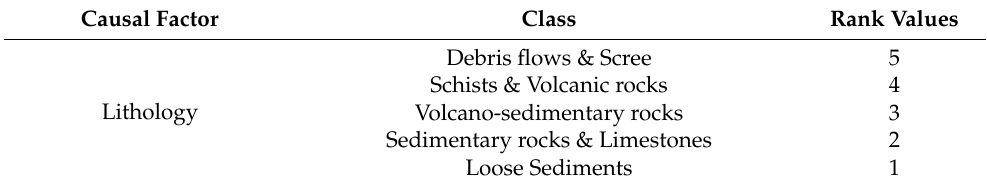
Figure 4. Schematic workflow of the implemented multi-hazard approach. Table 2. Landslide causal factors classification and ranks in Milos and Thira